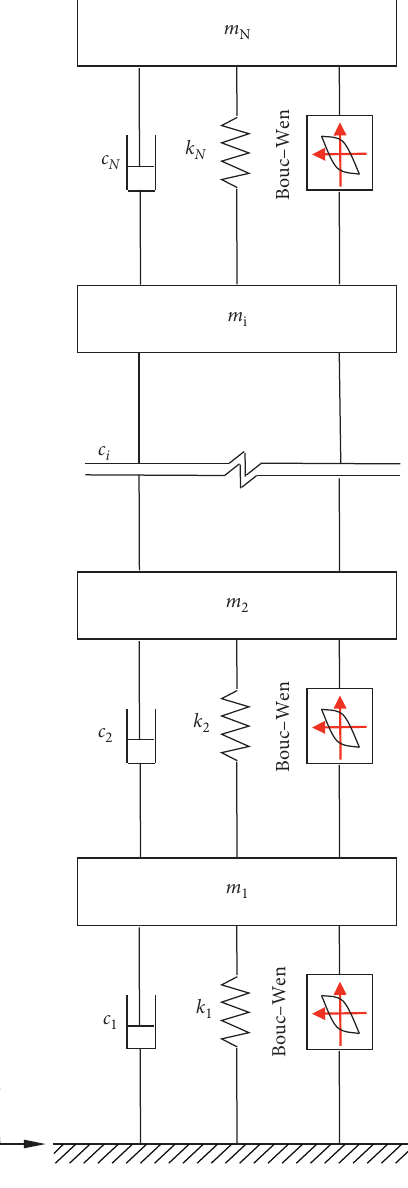
Figure 1: Model of a base-isolation system with passive MR